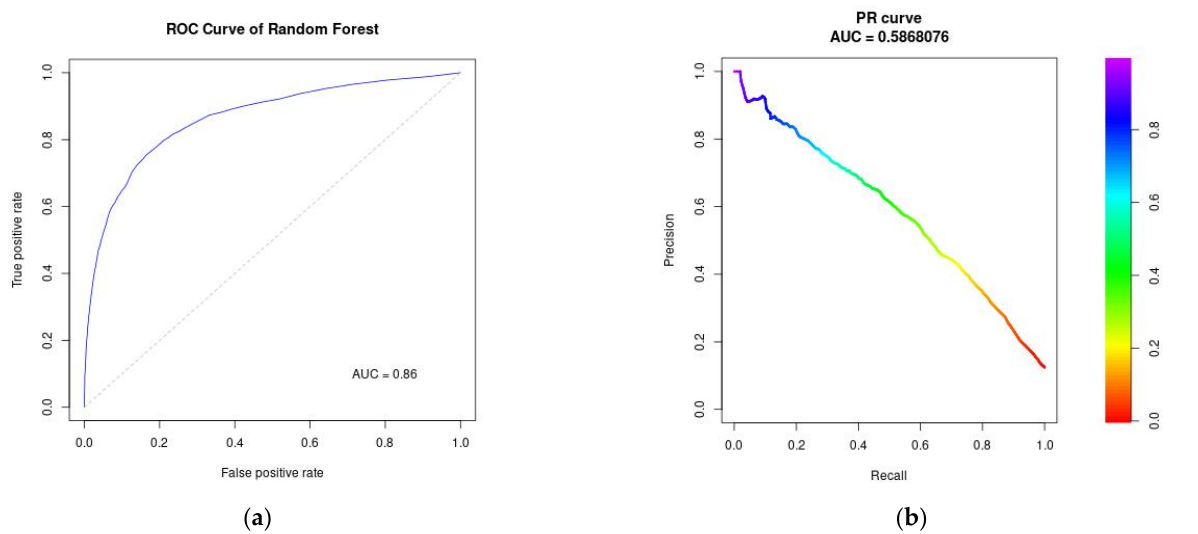
Figure 2. Performance evaluation for Random Forest ( a ) ROC curve; ( b ) Precision-Recall curve.